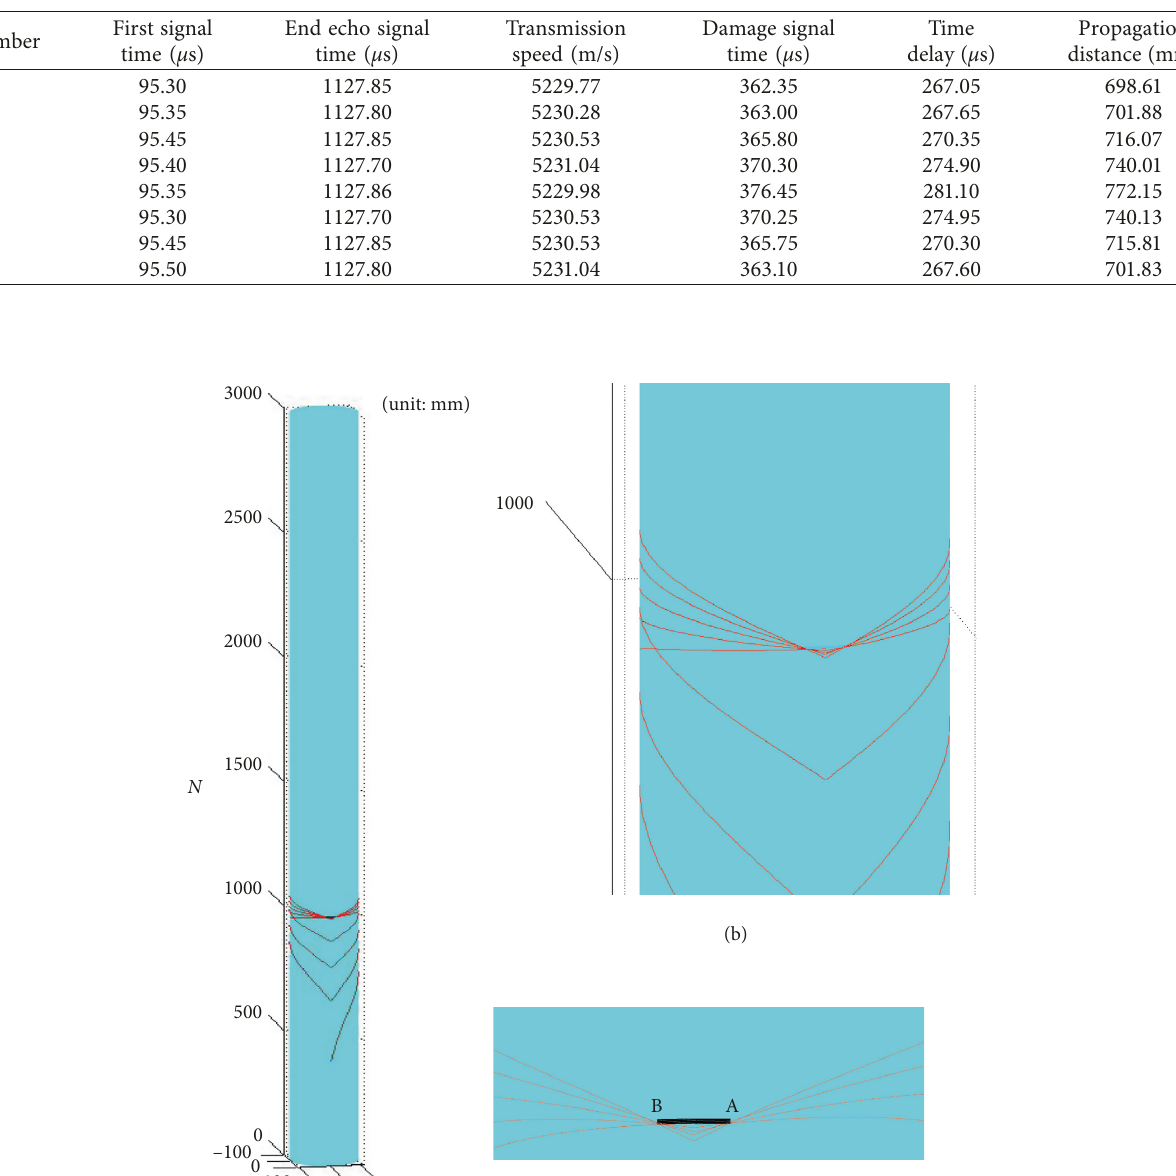
Table 2: Guide wave propagation distances between the signal receiving point and defect reflection point.